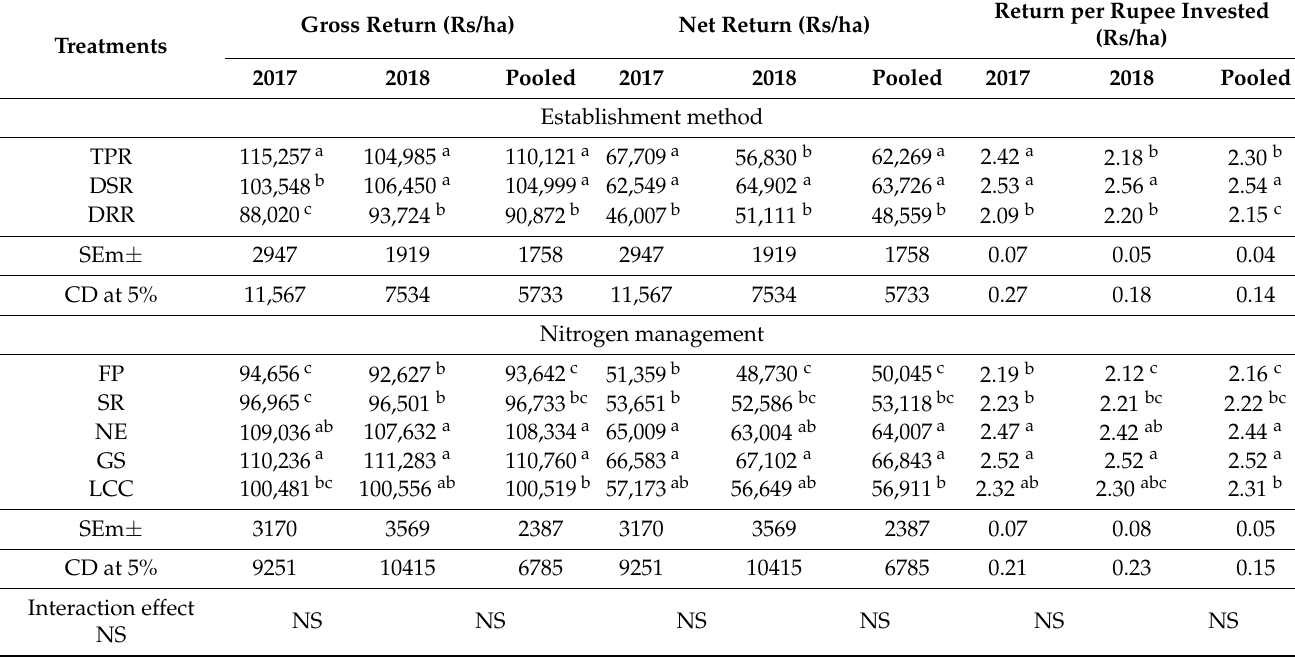
Table 7. Influence of crop establishment methods and nitrogen management on the economics of “Pratikhya” Kharif rice variety.